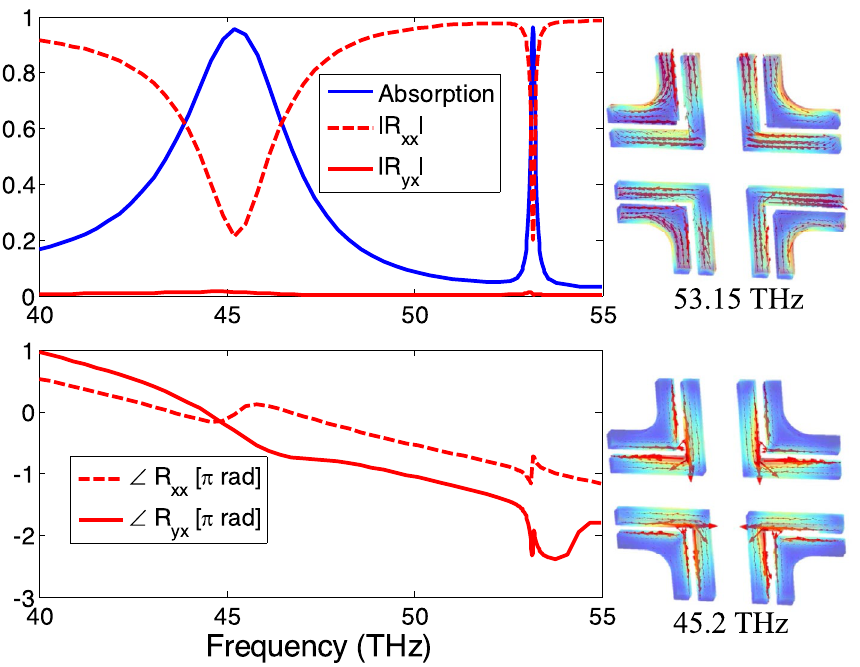
Figure 8. The reflectance and the absorption spectra of the phase-compensated dual band absorber metasurface. The insets show the surface current density vectors at the resonant frequencies of 53.15 THz and 45.2 THz corresponding to the resonances of the larger and smaller L-shaped structures, respectively. The chiral current distribution is provided in instantaneous time varying form in supplementary